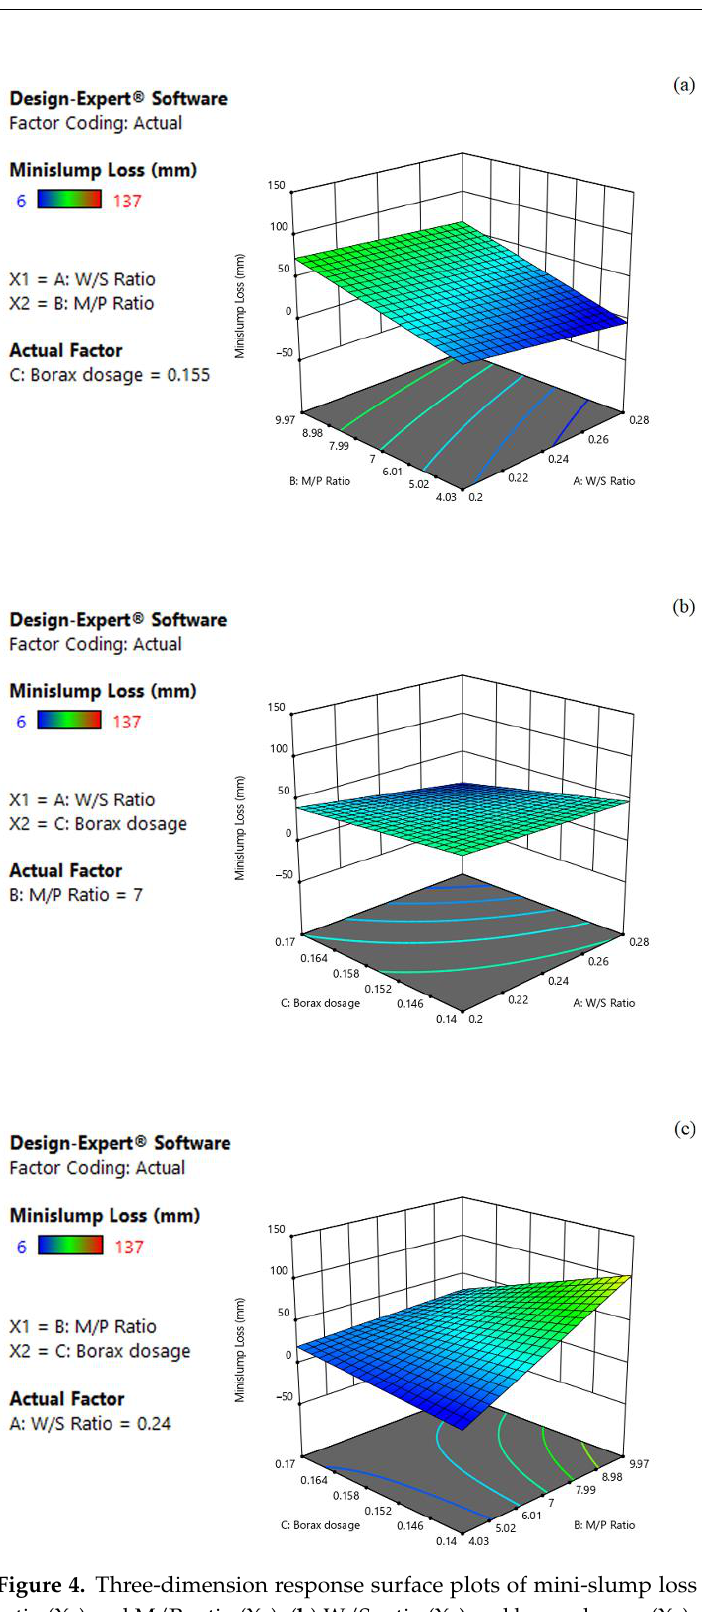
Figure 4. Three-dimension response surface plots of mini-slump loss (Y 2 ) in relation to: ( a ) W/S ratio (X 1 ) and M/P ratio (X 2 ); ( b ) W/S ratio (X 1 ) and borax dosage (X 3 ); ( c ) M/P ratio (X 2 ) and borax dosage (X 3 ).